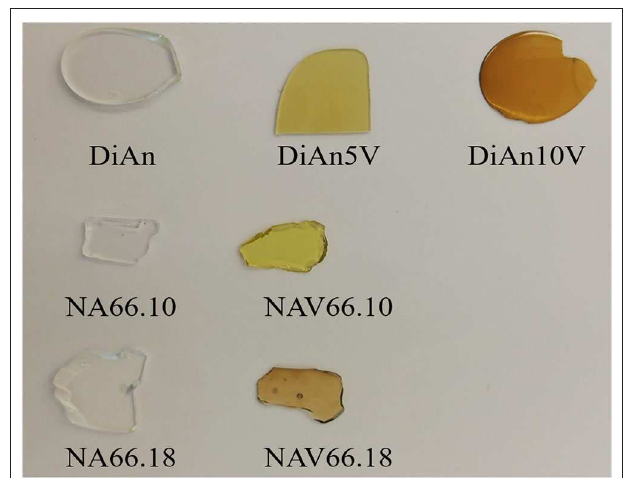
FIGURE 1 | Glasses synthesized in this study. Pristine NA66.10, NA66.18, and DiAn glasses are shown along with the V-doped ones: NAV66.10, NAV66.18, DiAn5V, and